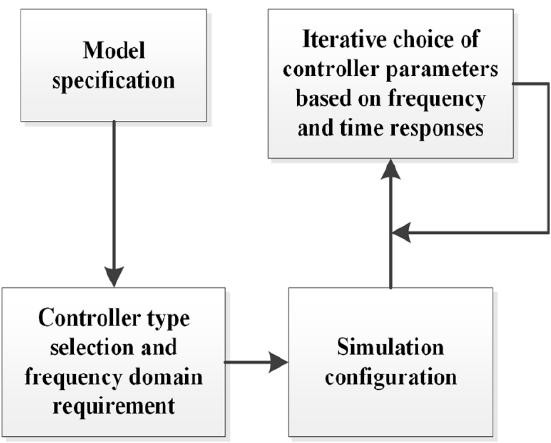
Figure 6. Work flow description of the tool.